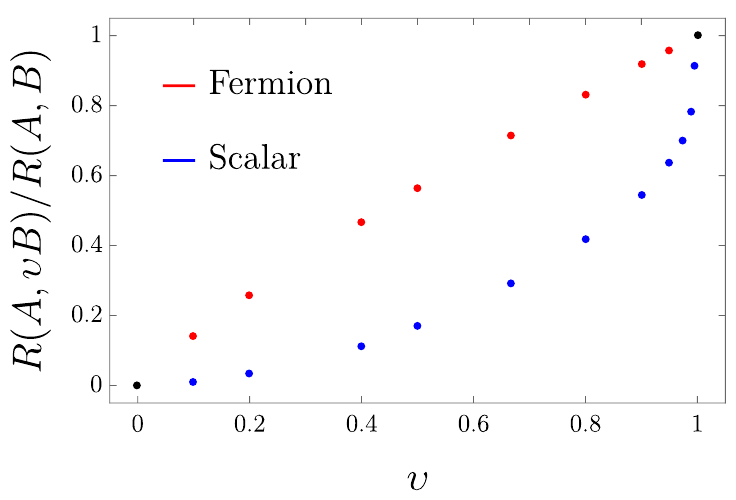
Figure 4 . For a free fermion and a chiral scalar, we plot the reflected entropy corresponding to a fixed interval A and a region υB consisting of two intervals obtained as follows: given a single interval B identical to A and with a fixed cross-ratio η = 1 / 9 , we remove a certain subset of B symmetric around its center so that we keep a total fraction υ of B . For instance, υ = 2 / 5 means that we have divided B in five identical pieces and we have computed reflected entropy for A and the pair of intervals resulting from removing the three intermediate fifths of B . The result appears normalized by R ( A, B ) , i.e. by the one obtained by considering the full interval B . The black dots correspond to the limit cases and are shared by the two